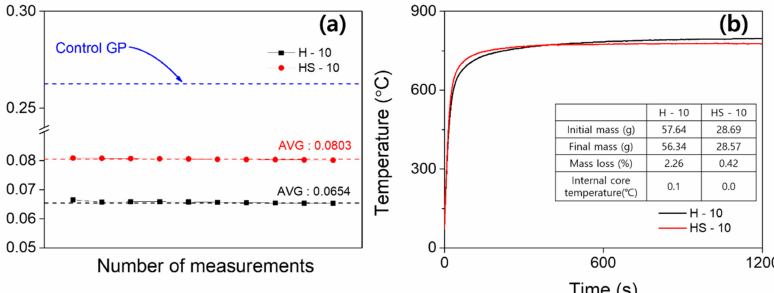
Figure 7. ( a ) Thermal conductivity of H , HS samples, and ( b ) time-dependent temperature change of the materials in non-combustible test according to ISO